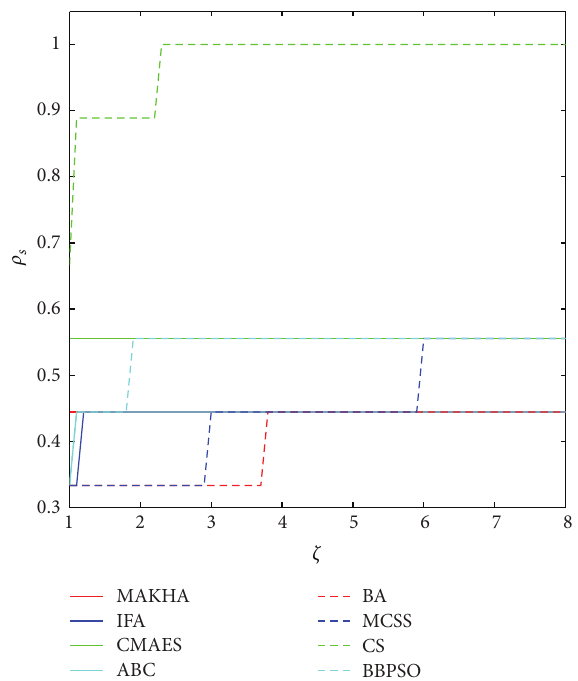
Figure 10: Performance profile (PP) of the reliability metric of the eightmetaheuristics for the 9 phase stability and equilibrium problems.